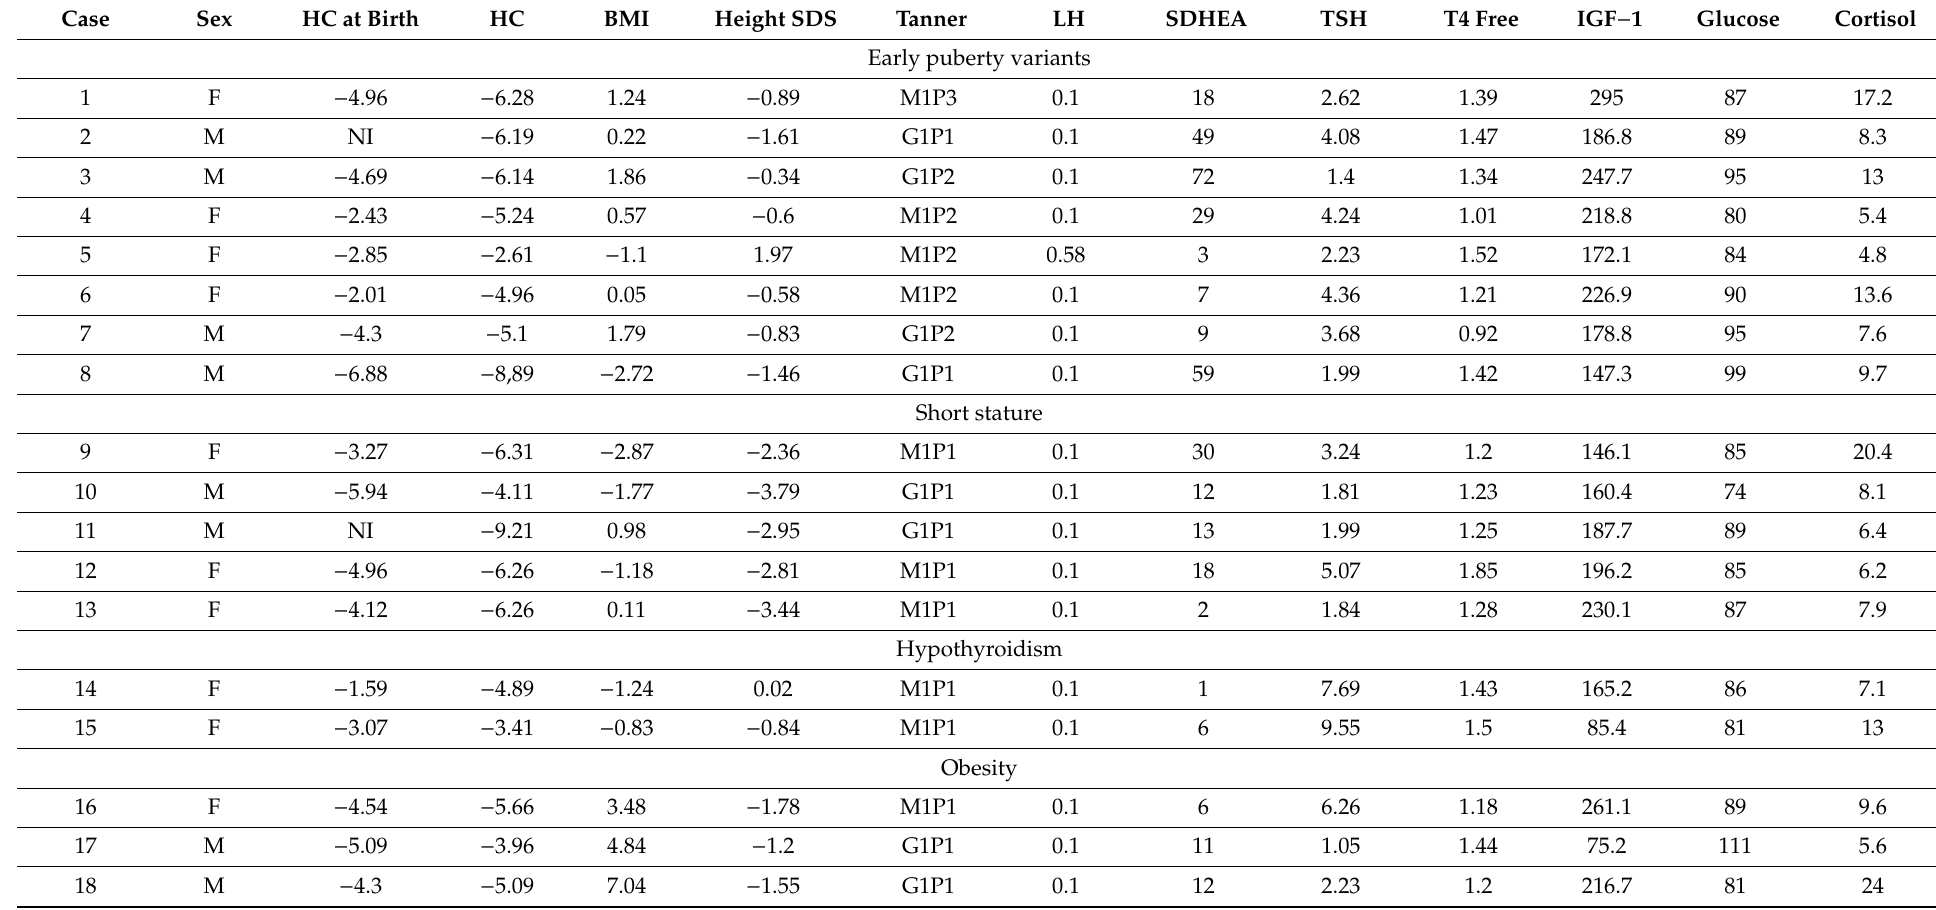
Table 3. Clinical and laboratory characterization of the 30 children with Zika-related microcephaly assessed with endocrine